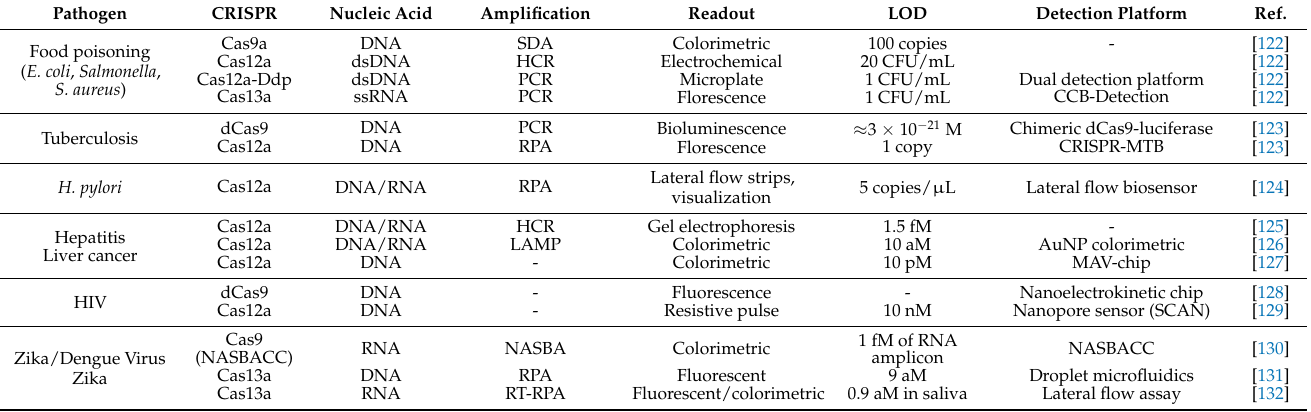
Table 1. Overview of detection of pathogens along with the Cas